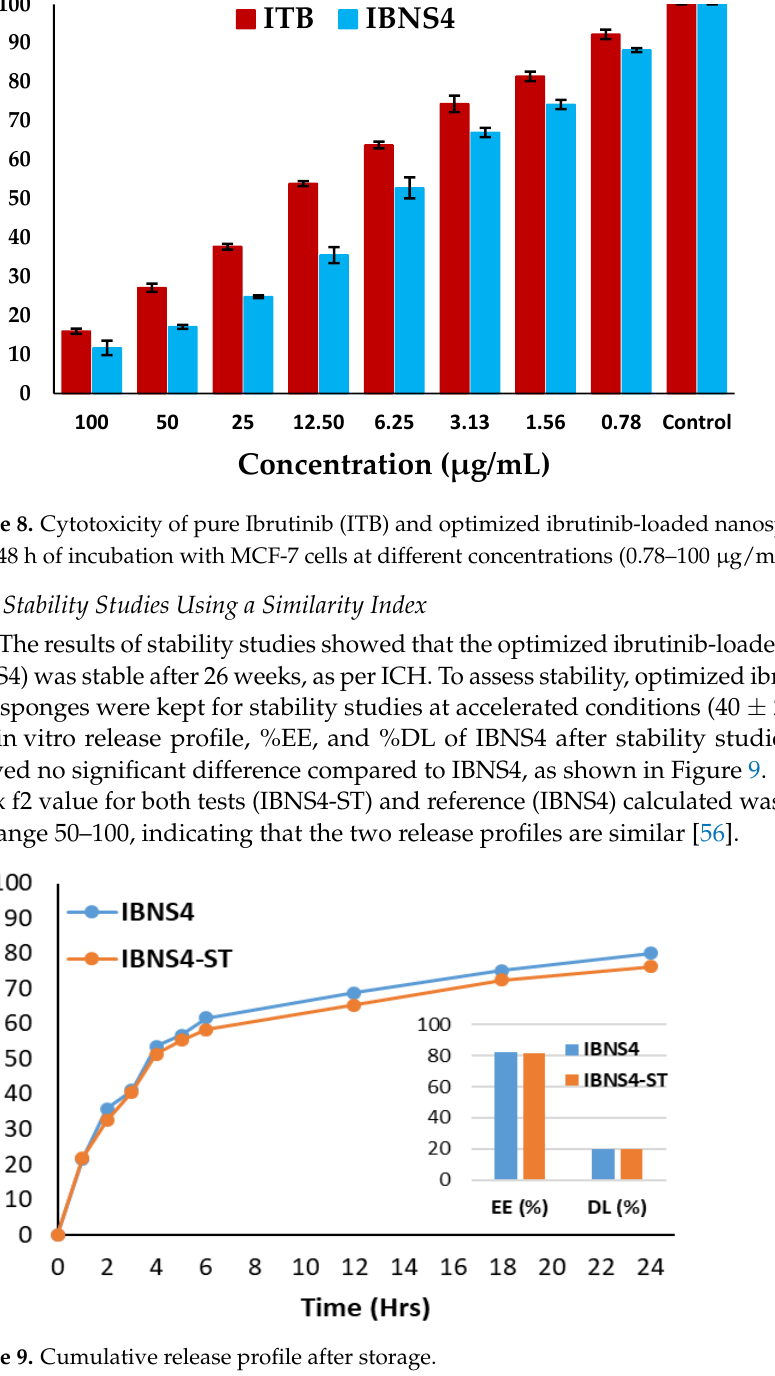
12 of 16 Figure 7. Cumulative (%) release of ITB and IBNS4. 3.9. Cytotoxicity Assay on MCF-7 The optimized nanosponge (IBNS4) exhibited a significant reduction in cell viability (88.24%, 74.27%, 67.10%, 52.84%, 35.55%, 24.86%, 17.12%, and 11.70% at 0.78, 1.56, 3.13, 6.25, 12.50, 25, 50, and 100 μg/mL) in comparison with pure drug IBT (92.29%, 81.49%,